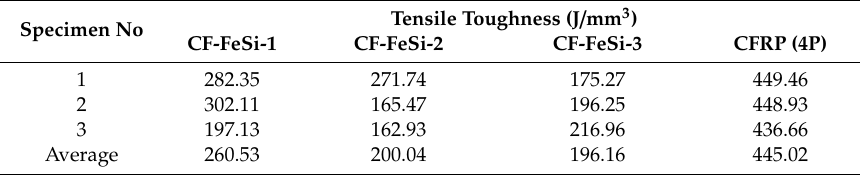
Table 8. Tensile toughness of the composites.